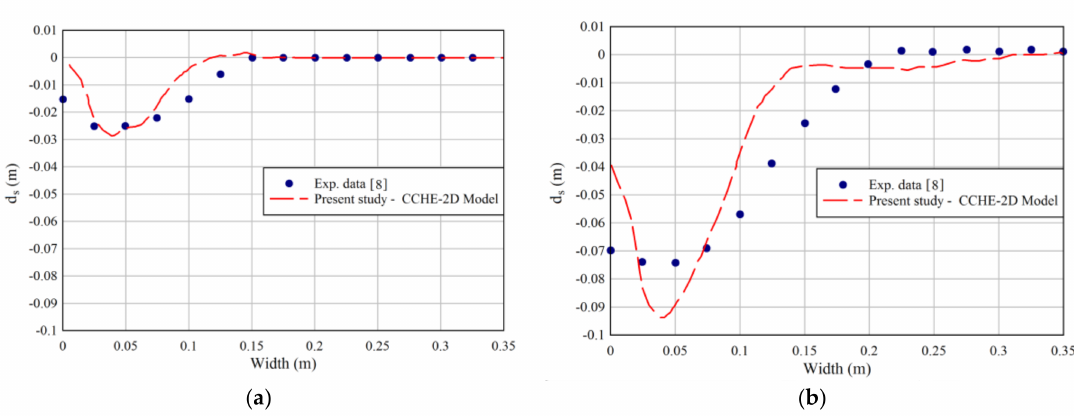
Figure 7. Comparison between experimental data and numerical results ( θ = 75 ◦ ). ( a ) Run 5; ( b ) Run 6.